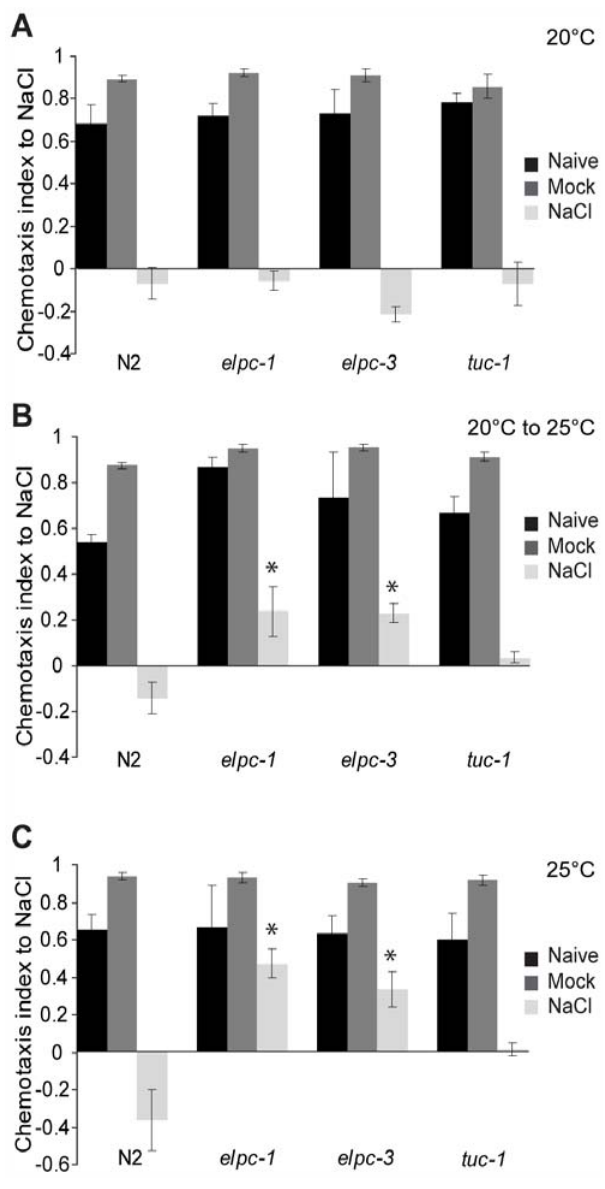
Figure 5. The elp-1(tm2149) and elpc-3(tm3120) mutants show a salt chemotaxis learning defect. For each strain there are three conditions. ‘NaCl’ indicates worms that were preconditioned on a plate containing 100 mM NaCl for 4 hours prior to the chemotaxis assay. ‘Mock’ indicates that worms were pretreated on NaCl-free plate for 4 hours before assay. ‘Naive’ indicates worms that were assayed without any preconditioning. The chemotaxis index after 30 min of assay is displayed. The assay was repeated four times. Error bars denote standard deviations. Asterisk indicates a significant difference from wild type N2 (*p , 0.01 by student’s t test). (A) Young adult worms that had been raised at 20 u C. (B) Temperature shifted animals. Synchronized eggs were grown at 20 u C to the 2 nd larval stage (L2). L2 larvae were then shifted to 25 u C and cultured until they had become young adults. (C) Young adult worms from a strain that had been maintained at 25 u C for several generations.